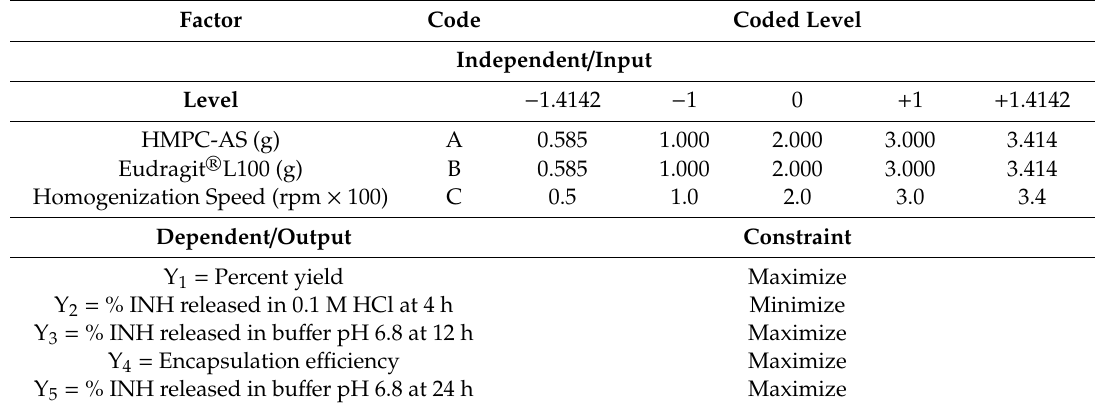
Table 1. Coded levels for input variables and responses used for the hybrid experimental